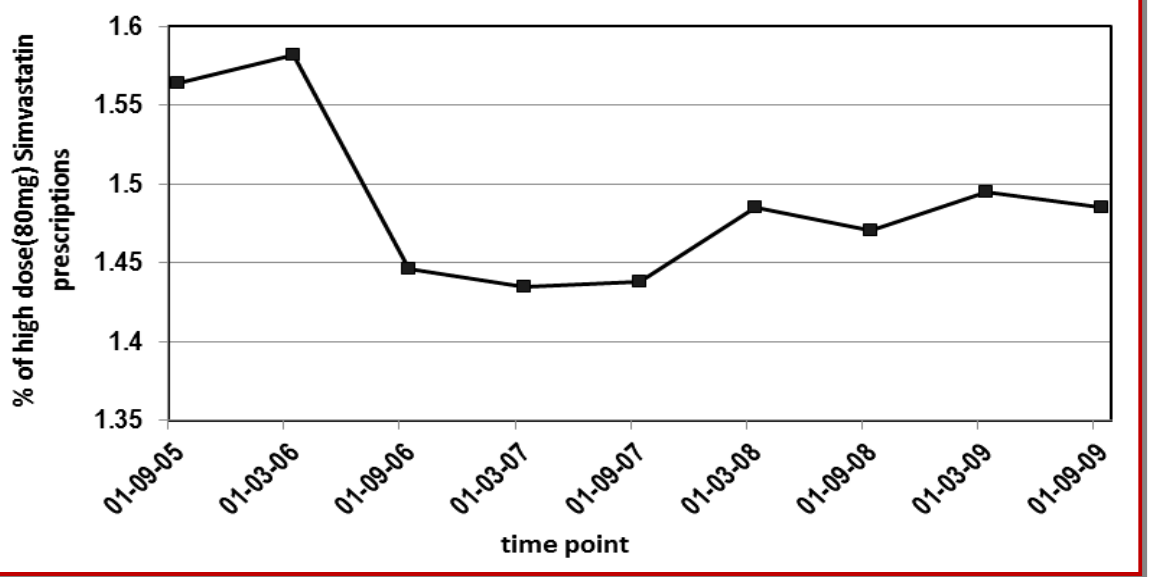
Figure 3: Percentages of high dose (80 mg) simvastatin prescriptions in Scotland on different time point